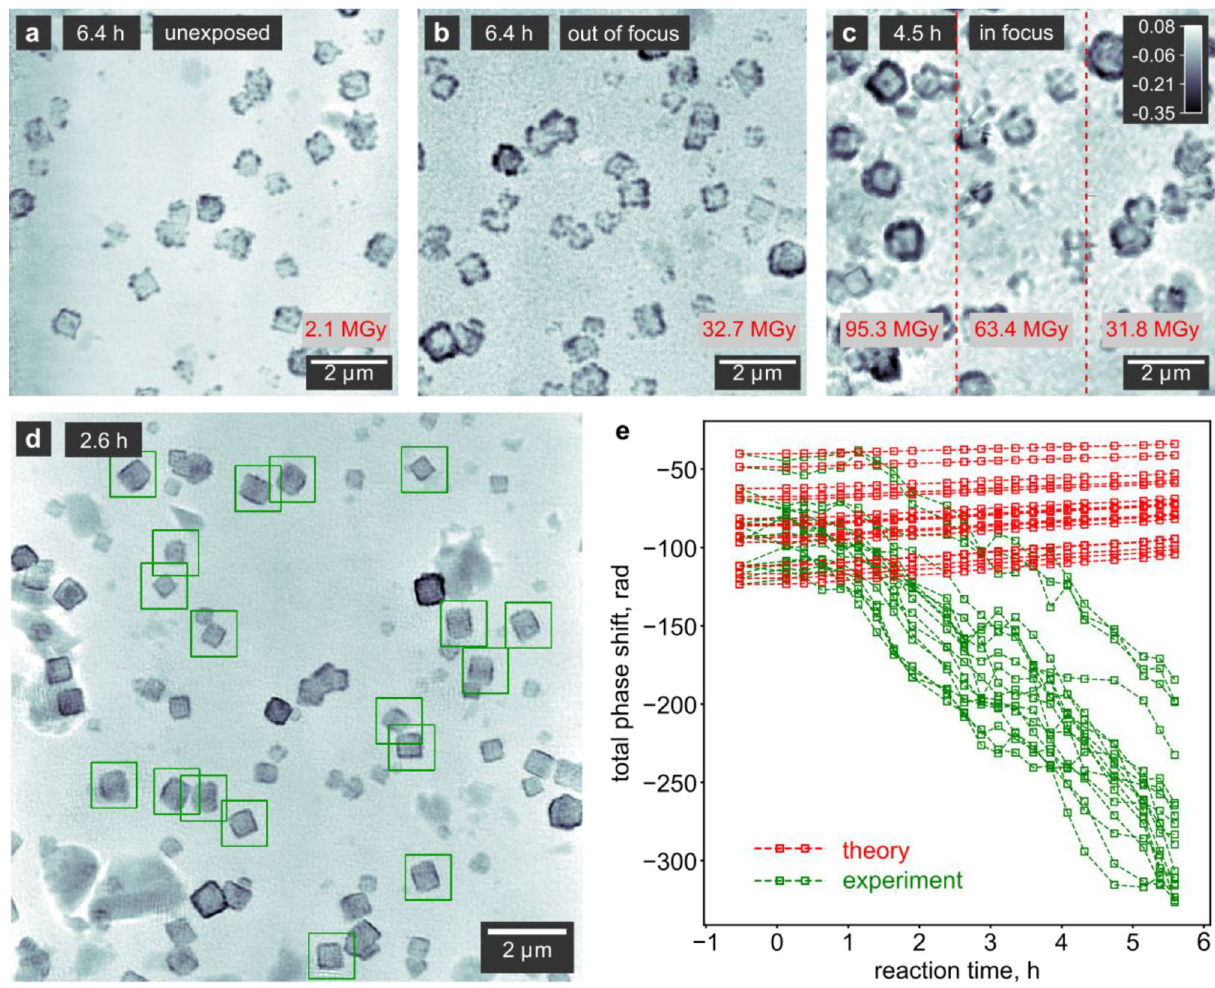
Figure 5. Quantification of radiation damage. ( a , b ) In situ ptychographic reconstructions during the GRR obtained at the same reaction time, showing ( a ) a region previously unexposed to X-rays and ( b ) a region continuously exposed for the preceding 6.4 h in the defocus of the X-ray beam. ( c ) Ptychographic reconstruction of a GRR exposed in the X-ray focus with a shifting field of view. The gray scale indicates the phase shift in radian. ( d ) Ptychographic reconstruction highlighting a number of areas around individual particles used for the quantitative phase analysis. The reconstructed pixel size is 14.51 nm. ( e ) Expected evolution of the total phase shift of the particles (red) highlighted in ( d ), assuming a full conversion from Cu 2 O to Au, compared to the measured phase shift (green). We applied a moving average with a window size of 3 data points. A larger negative phase shift indicates more material. Due to the unknown amounts of Cu 2 O and Au in the sample, we can not convert the measured phase shift into an electron count (see Supplementary Note 5 for